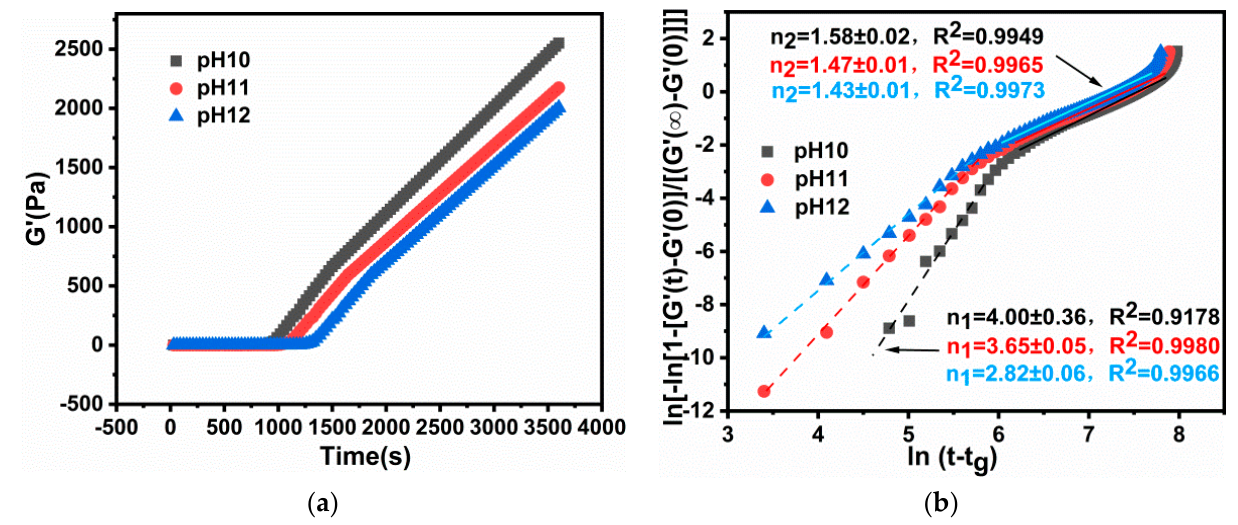
Figure 3. ( a ) Storage modulus. ( b ) Avrami dynamics model during gelation at pH 10.0 to 12.0. Table 2. Gelation kinetics parameters of PEG/PAMAM hydrogels (pH